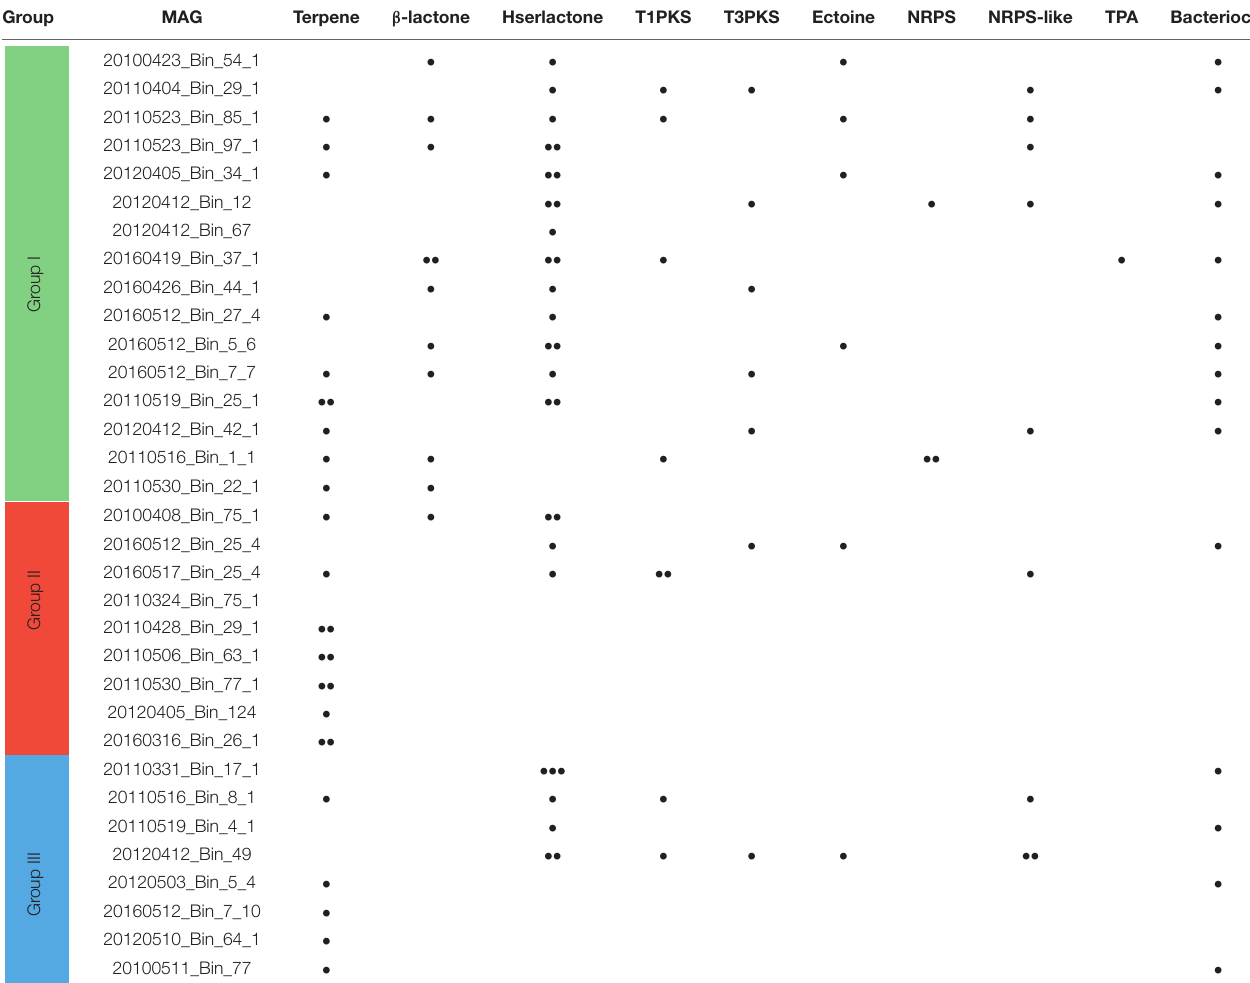
TABLE 1 | Putative biosynthetic gene clusters required for the production of secondary metabolites in Rhodobacterales MAGs. Group MAG